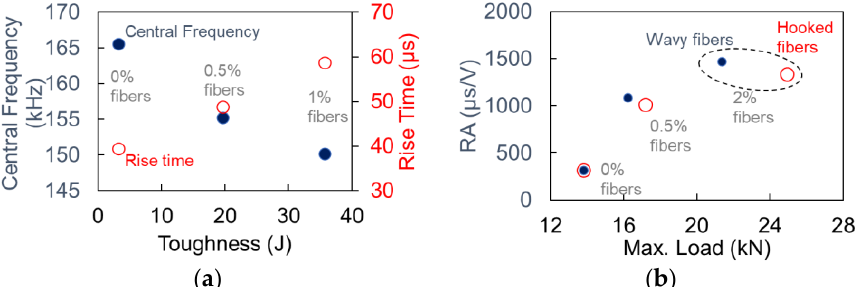
Figure 10. ( a ) Correlation between AE parameters obtained from the elastic regime and toughness of SFRC under 3p- bending. ( b ) Correlation between RA value and max. load for SFRC under 4p-bending and different contents and types of fibers. 4p-bending and different contents and types of